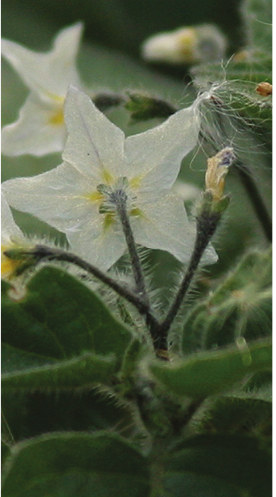
Figure 2: S. villosum .